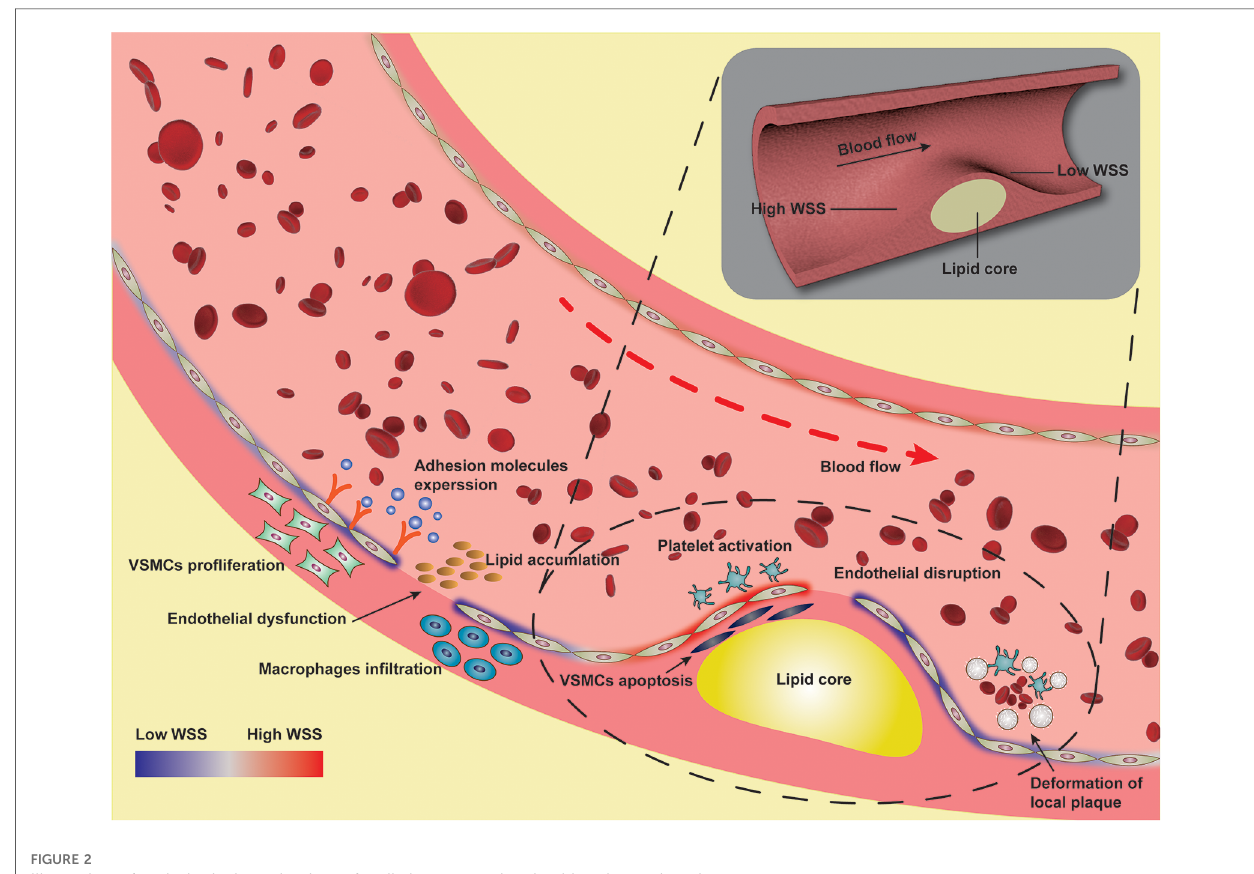
FIGURE 2 Illustration of pathological mechanism of wall shear stress involved in